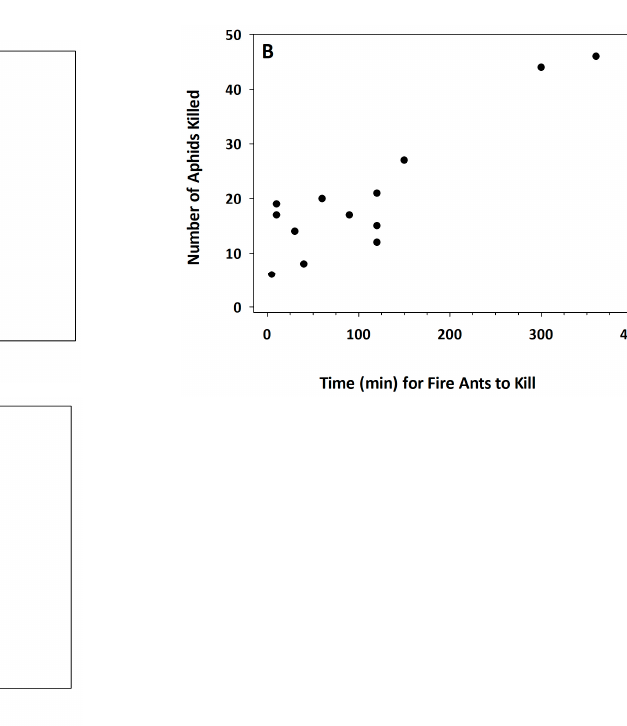
6 of 10 Figure 1 . A – E Images of R . padi nymphs and adults on barley leaf ( A ) and other R . padi individuals consumed by 3rd instar C. maculata ( B ). Image of S. invicta worker a tt acking 3rd instar C. maculata ( C ) in the arena. The blue arrow illustrates S. invicta biting C. maculata ; the orange arrow illustrates a drop of hemolymph exuding from the integument of C. maculata after being stung by S. invicta . Images of 3rd instar Sc. creperus not being a tt acked by S. invicta workers ( D , E ).